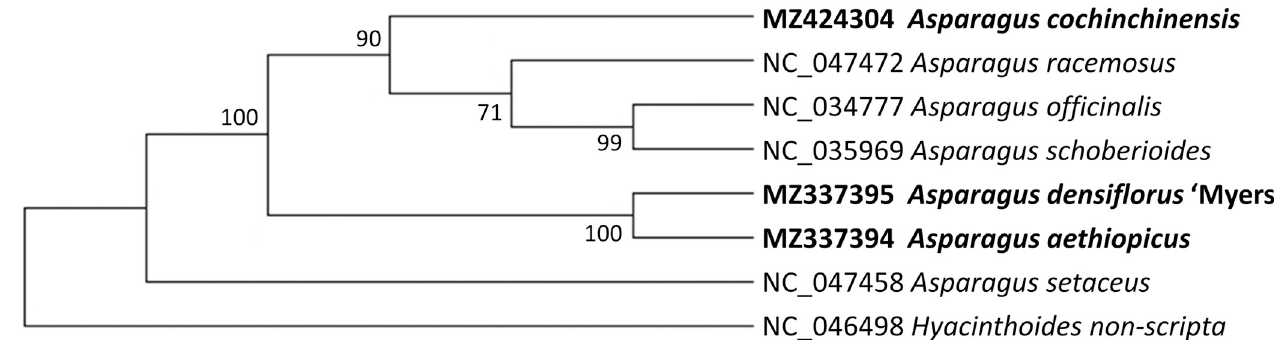
Fig 11. Maximum likelihood (ML) trees based on inverted repeats (IRs) for Asparagus . Numbers next to the nodes: bootstrap values on IR A and IR B . Bold taxa: the three newly assembled cpDNA genomes.